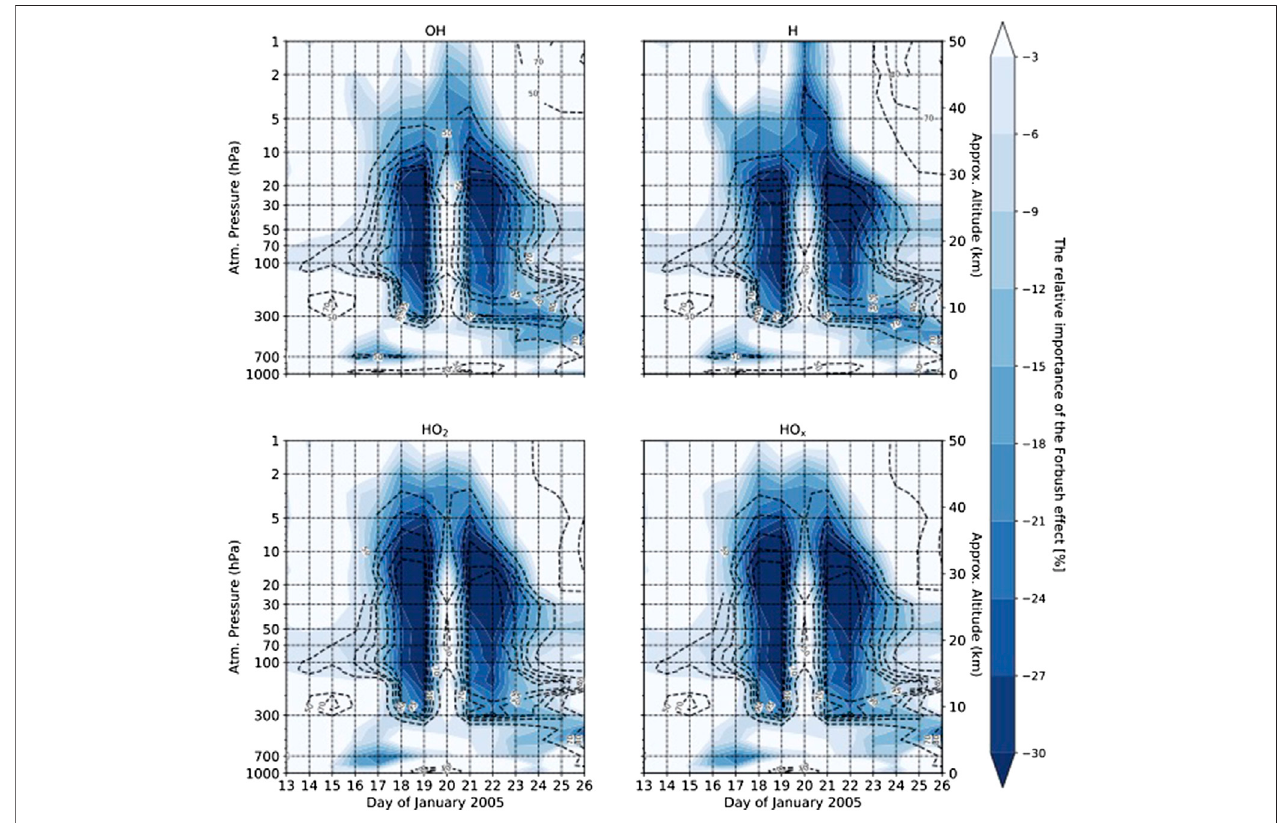
FIGURE 2 | The vertical profiles of temporal evaluations of anomalies in HO x over the northern polar atmosphere (90N-75N) during the period affected by Forbush decreases simulated with CCM SOCOLv2. The name of each HO x component is given above each panel. Dashed lines: the con fi dence level [in %].